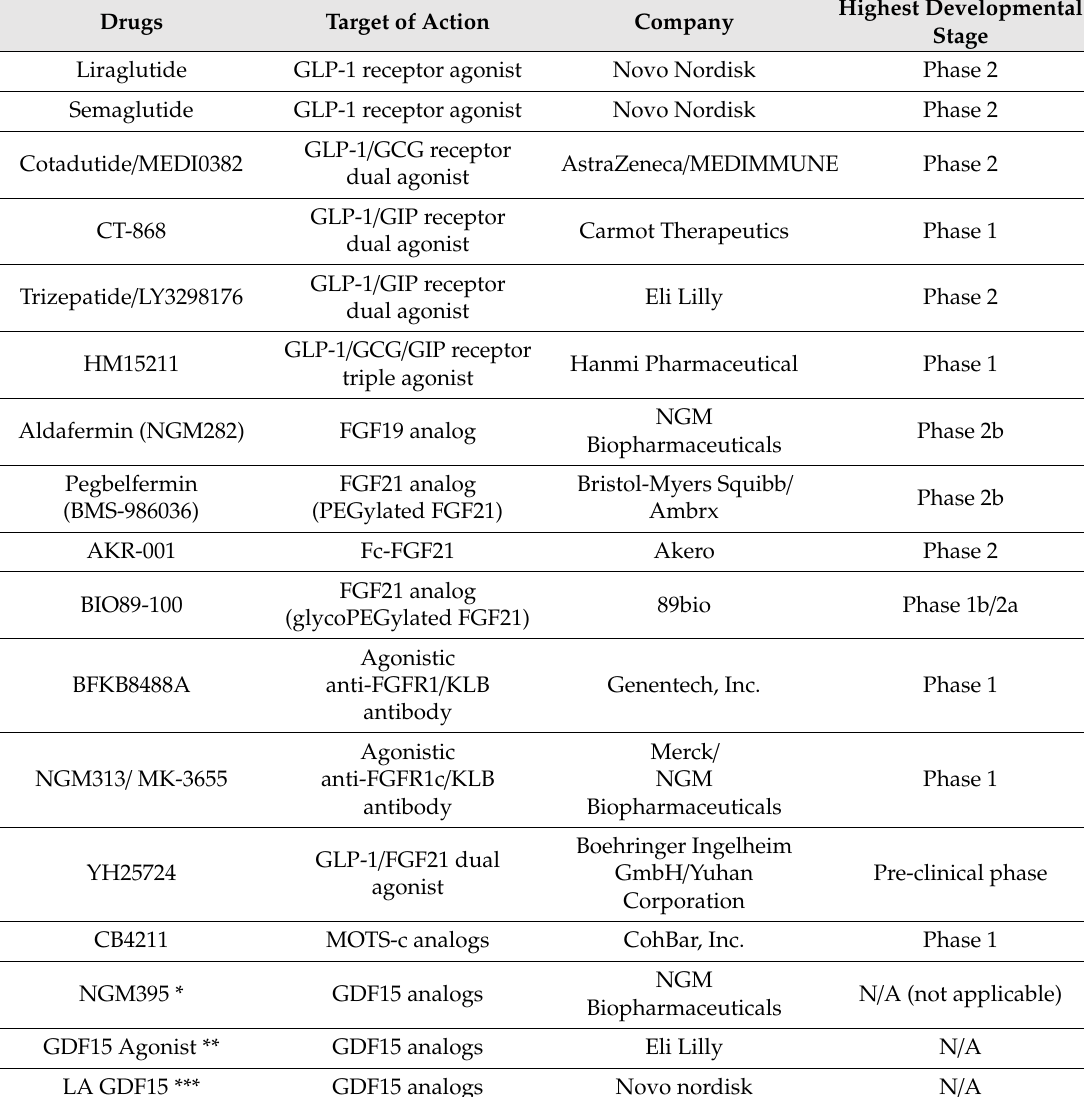
Table 1. Secretory protein-based pharmacological agents under development for treatment of nonalcoholic fatty liver disease (NAFLD) /